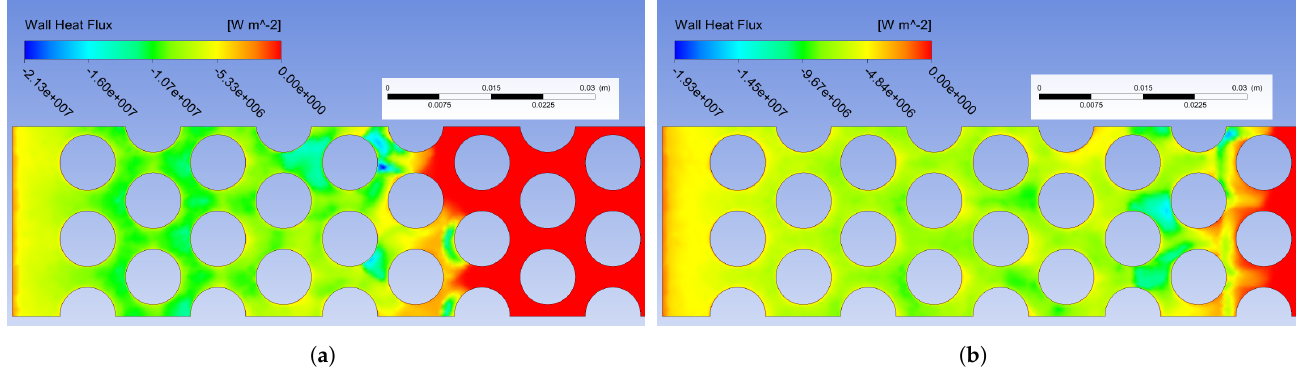
Figure 7. The wall heat flux during the detonation propagation at ( a ) t = 5.18 × 10 − 5 s and ( b ) t = 7.70 × 10 − 5